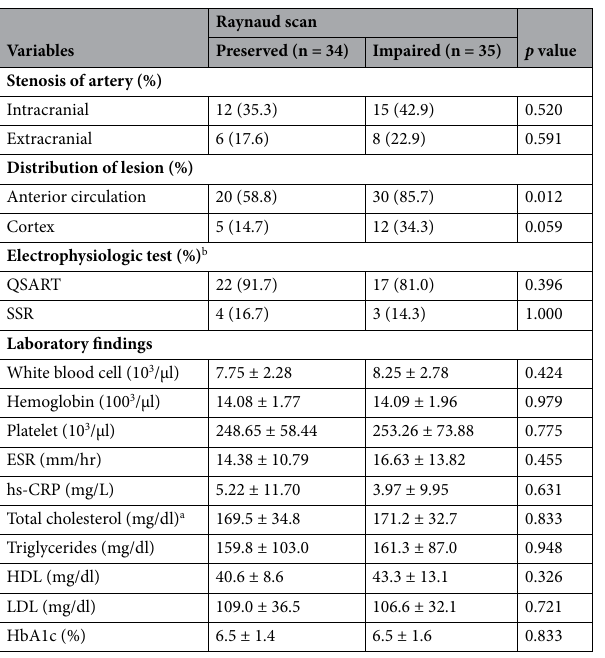
Table 2. Diagnostic features of study population. QSART Quantitative sudomotor axon reflex test, SSR sympathetic skin response, ESR erythrocyte sedimentation rate, hs-CRP high sensitivity C-reactive protein, HDL high density lipoprotein, LDL low density lipoprotein, HbA1c hemoglobin A1c. a Lipid profile (Preserved 33, Impaired 34). b Preserved 24, Impaired